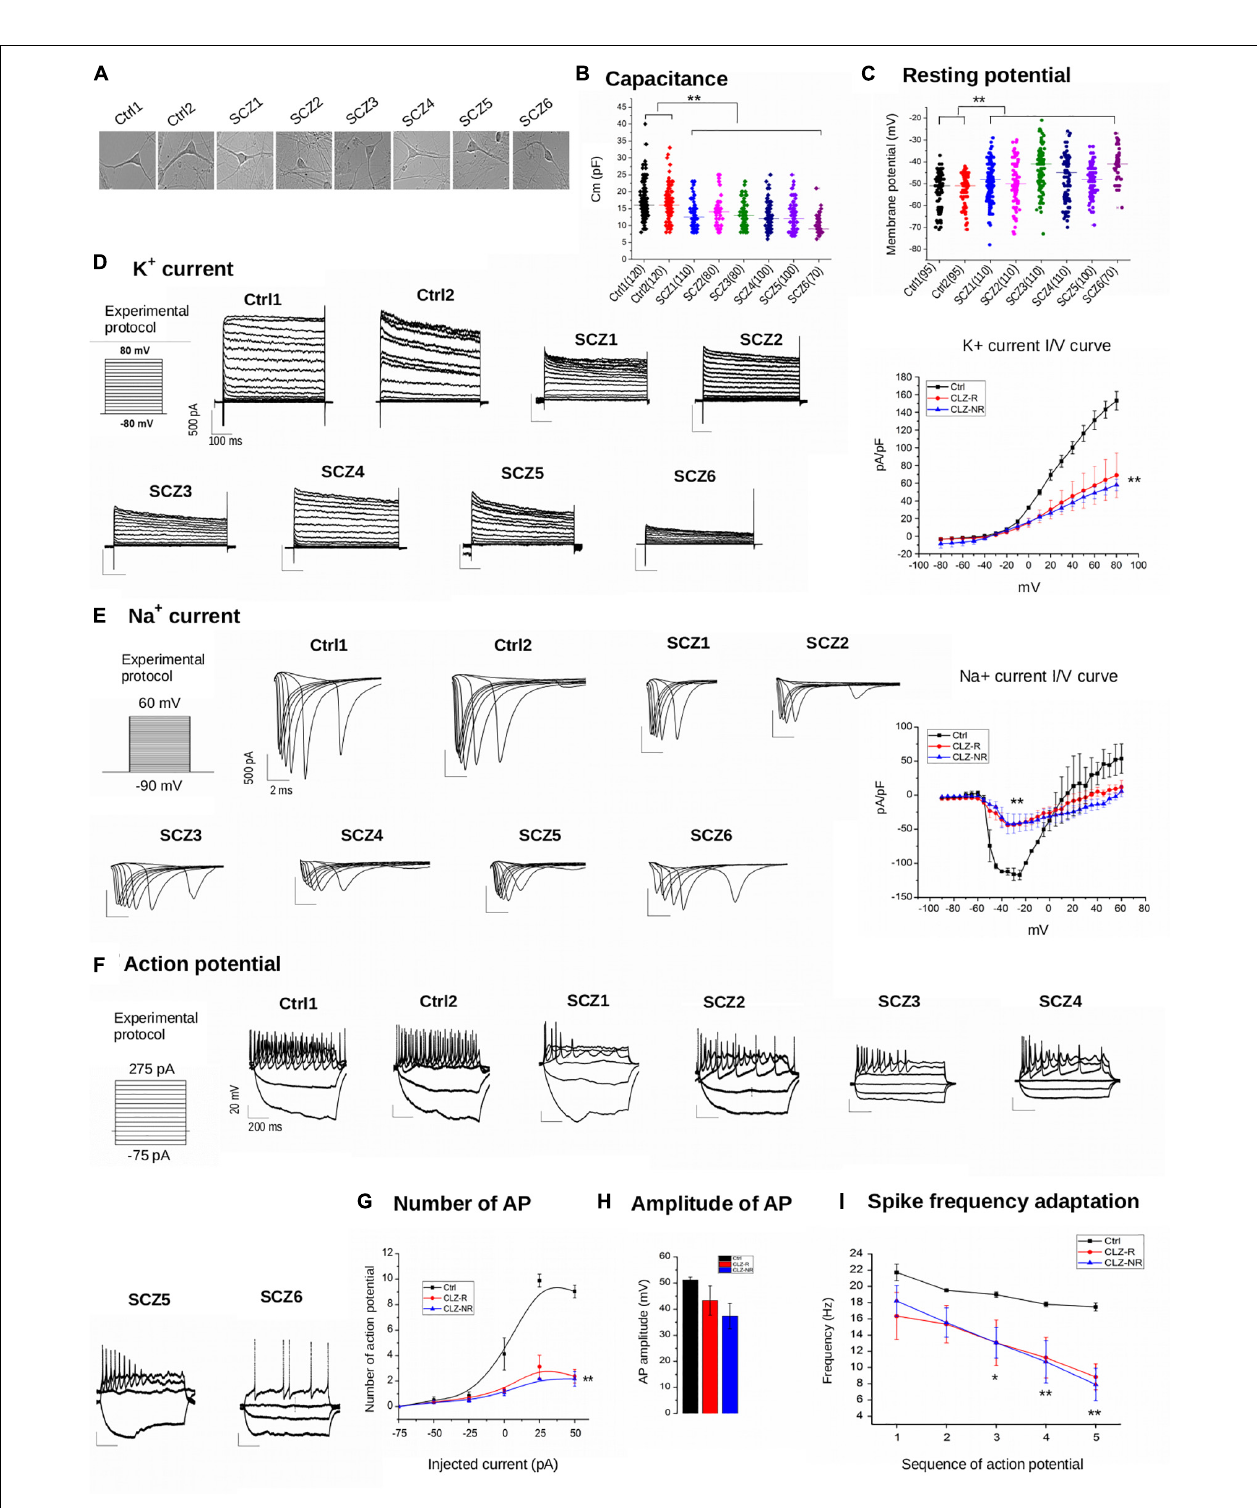
FIGURE 3 | Electrophysiology. (A) Representative examples of samples. (B) Capacitance of individual cell lines. (C) Resting potential of individual neuronal lines. (D) K + current density charts of individual neuronal lines and aggregated K + current I/V curve. (E) Na + current density charts and aggregated Na + current I/V curve. (F) Action potential charts of individual neuronal lines. (G) Number of potentials in subgroups of neuronal lines. (H) Amplitude of action potentials in subgroups of neuronal lines. (I) Spike frequency adaptation in subgroups of neuronal lines. Ctrl, neurons from control subjects ; CLZ-R, neurons from clozapine responsive schizophrenia patients ; CLZ-NR, neurons from clozapine non-responsive schizophrenia patients. The symbols represent significance levels: * p < 0.05; ** p < 0.001.